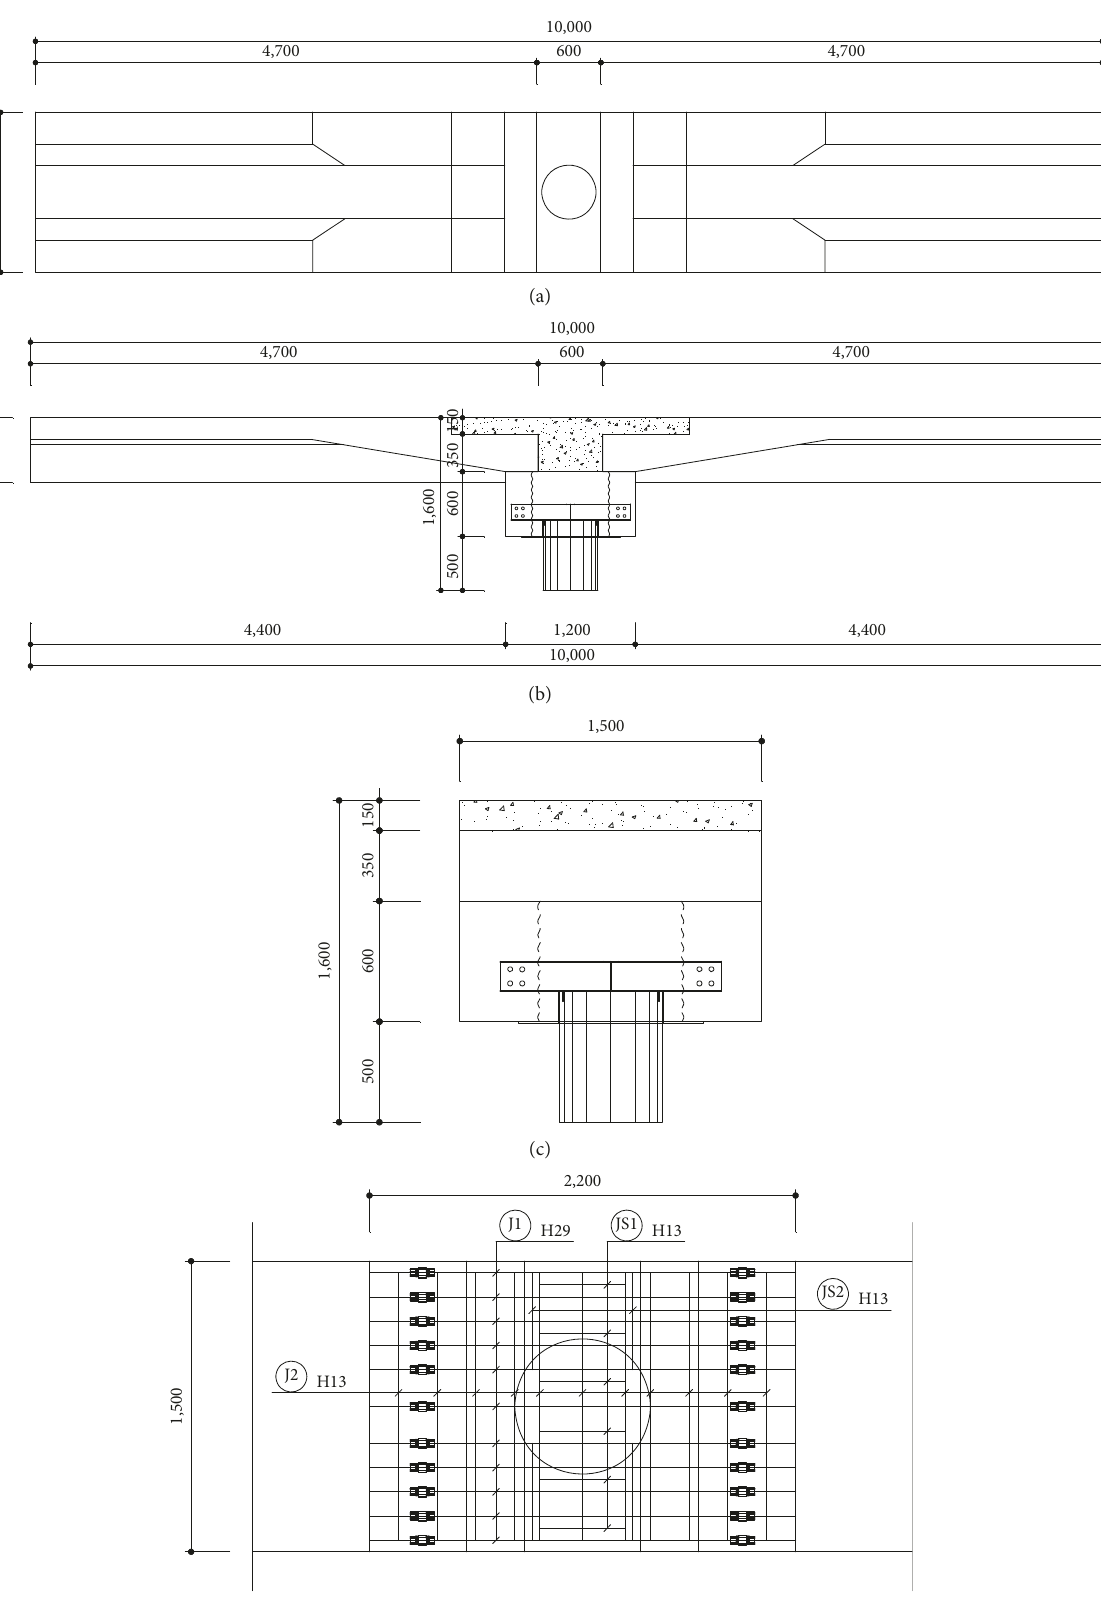
Figure 2: Geometry of test unit. (a) Floor plan, (b) longitudinal section, (c) cross-sectional view, and (d) cast-in-place section